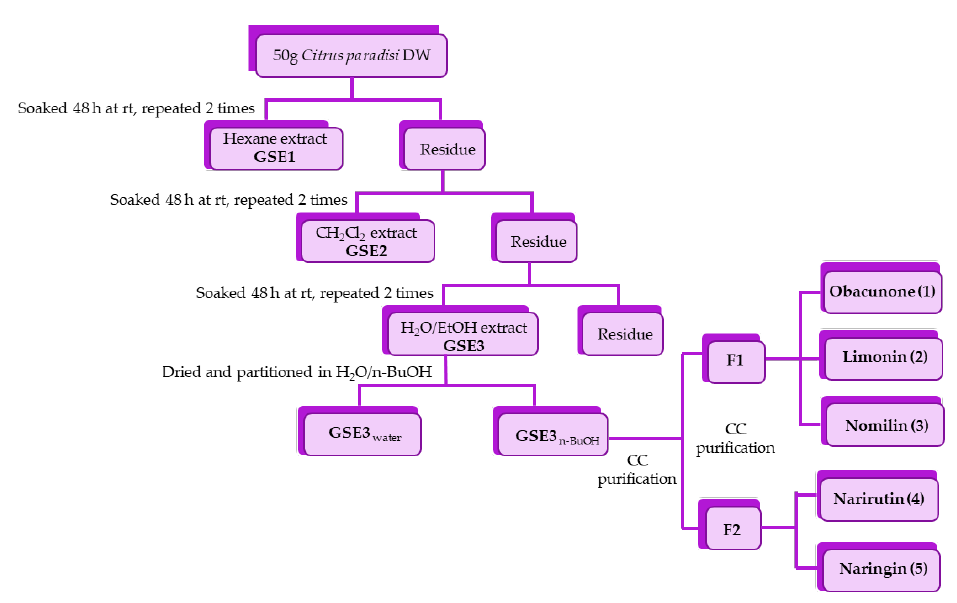
Figure 1. Schematic representation of the extraction–purification process from Citrus paradise seeds.